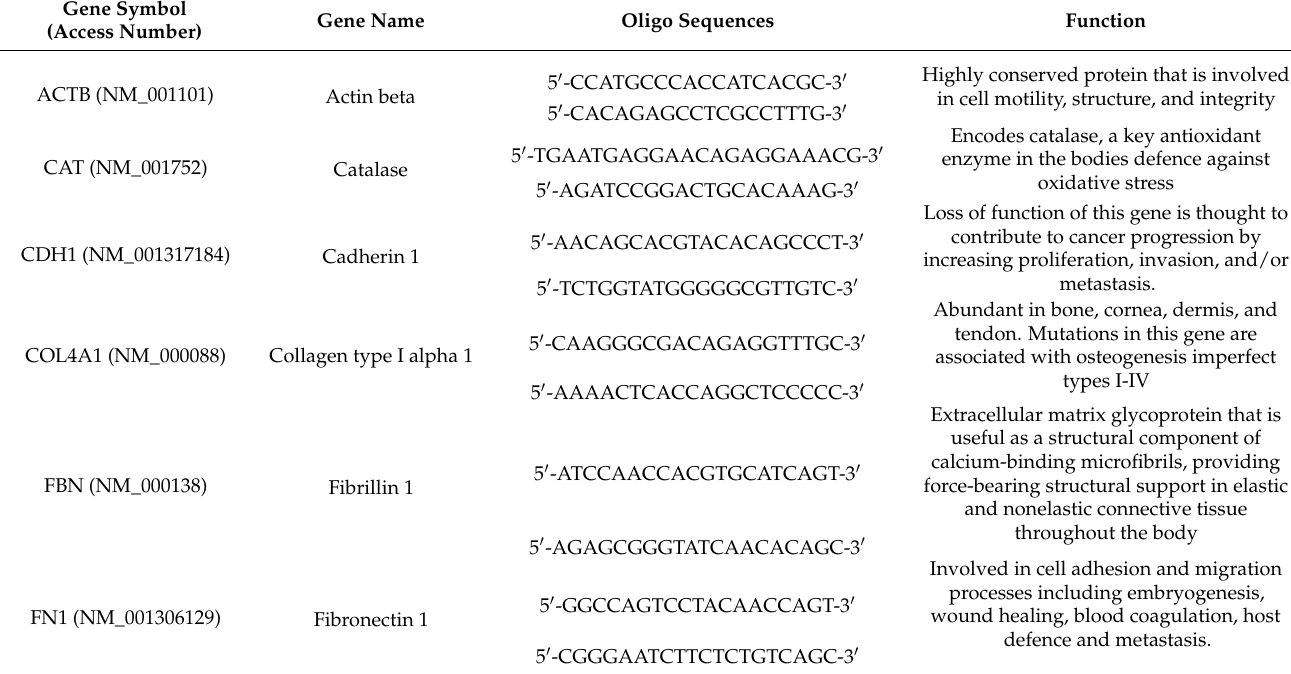
Table A1. Gene symbol, gene name, oligo sequences and function of gene-specific [19] used in RTqPCR